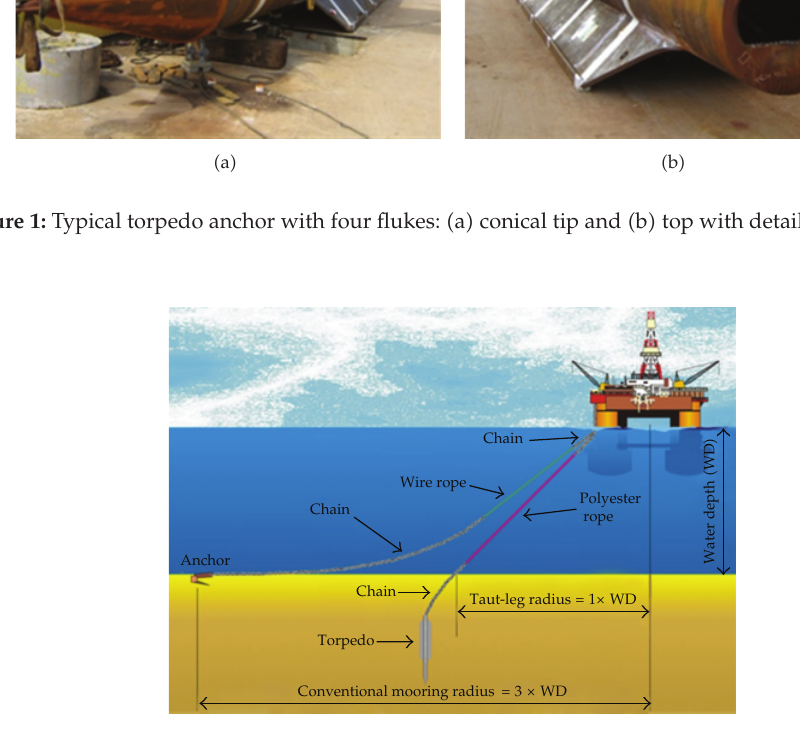
Figure 2: Torpedo anchor for mooring lines of floating